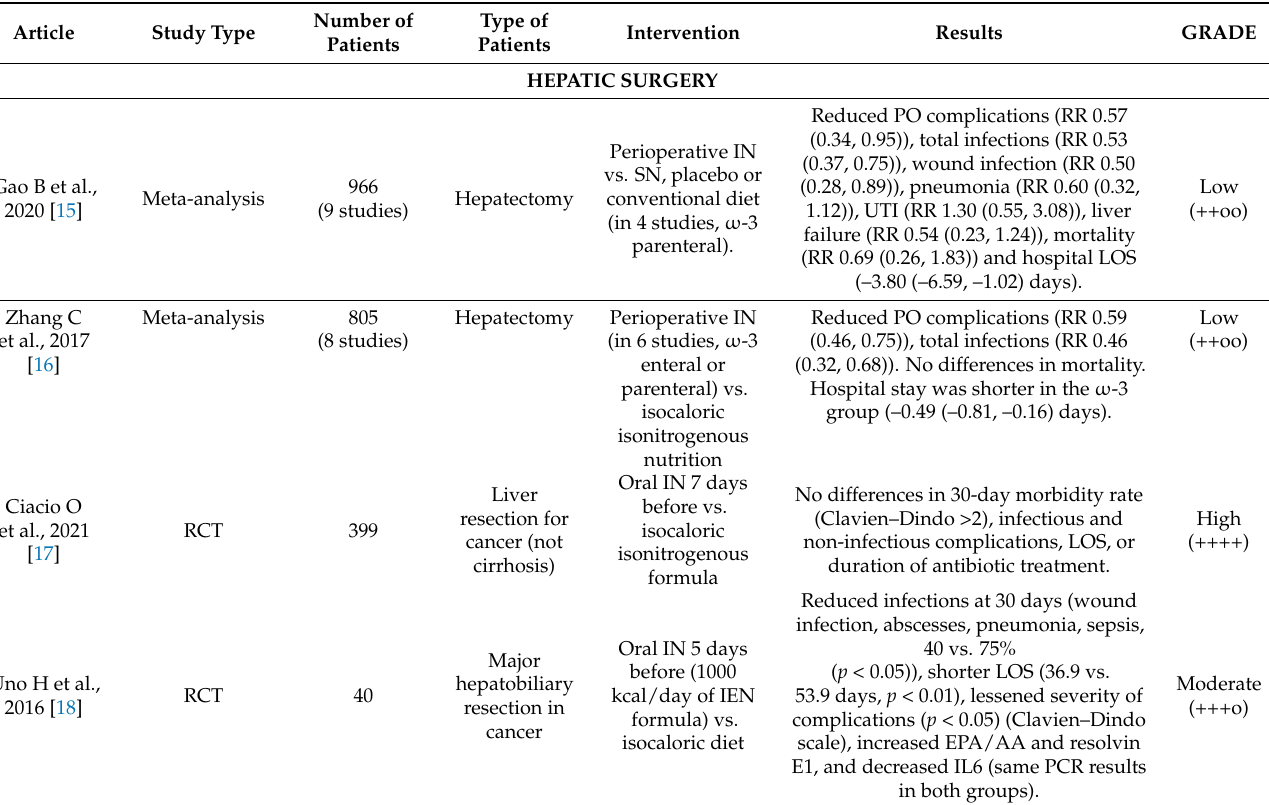
Table 4. Summary of the evidence obtained based on the search strategy and selection of articles with evidence rating using GRADEpro for hepatic surgery. IN: immunonutrition; SN: standard nutrition; ONS: oral nutrition supplement; PO: postoperative; LOS: length of